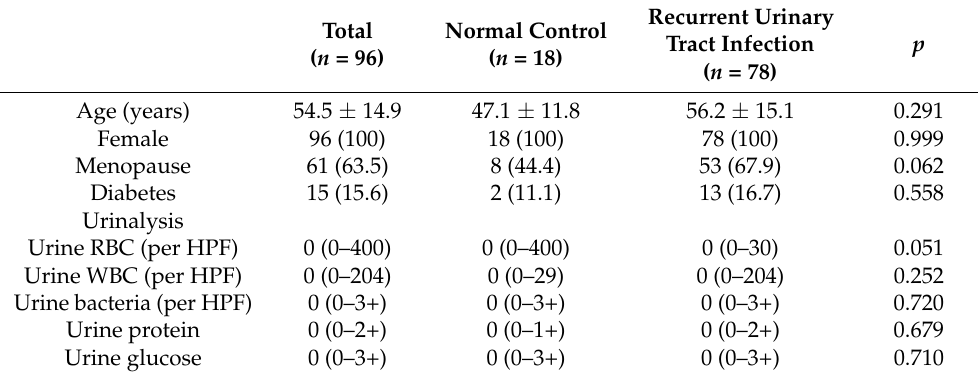
Table 1. Baseline characteristics of